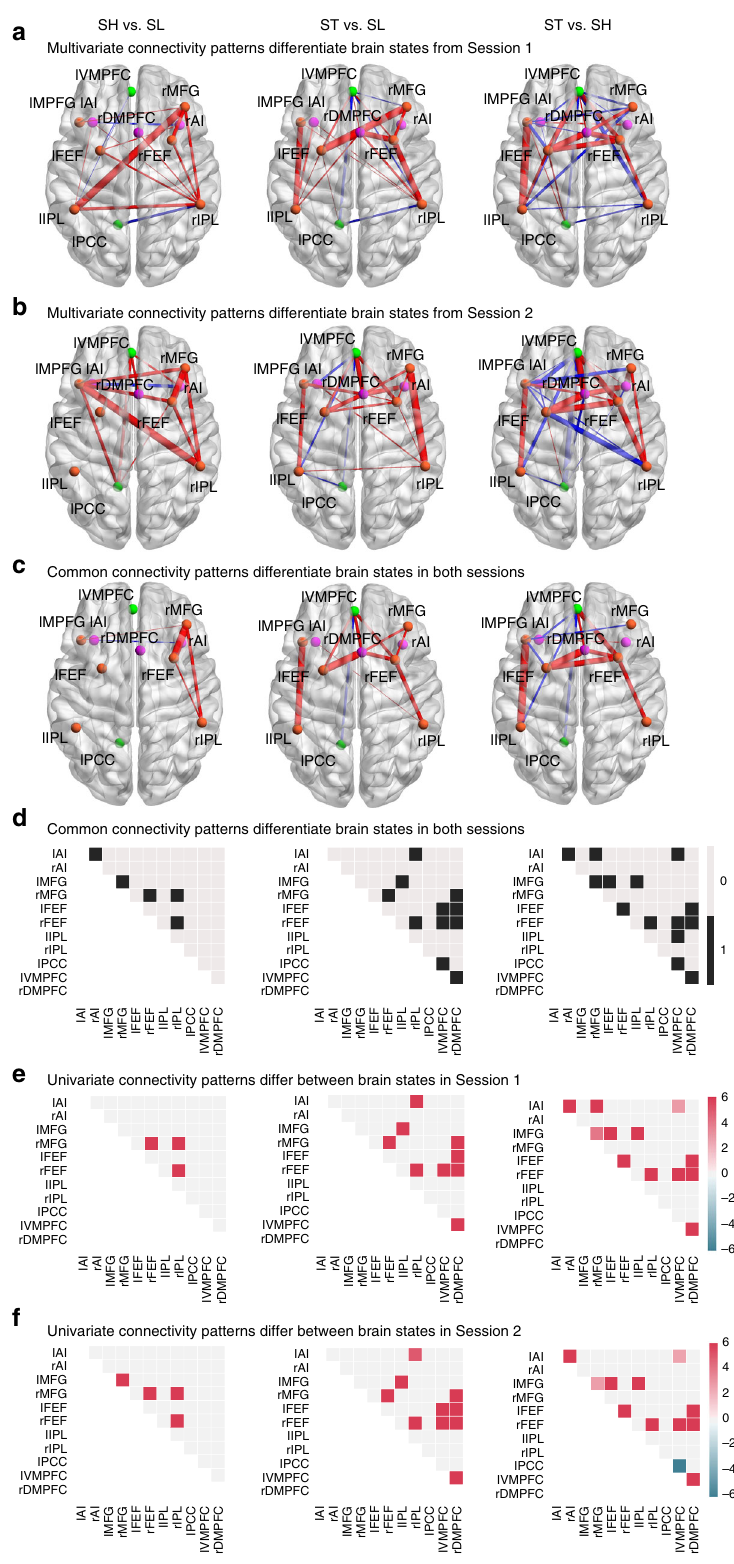
Fig. 6 Dynamic functional connectivity patterns that distinguish latent brain states. a , b Brain connectivity patterns that distinguish the latent states SH, SL, and ST in Sessions 1 and 2, respectively. The pink and orange nodes represent SN and CEN ROIs, respectively, activated during WM, while the green nodes represent DMN ROIs deactivated during WM. The red and blue edges represent positive and negative nonzero weights. c , d Common patterns of connectivity that distinguish latent states in both sessions. e , f Speci fi c links that showed signi fi cant differences in functional connectivity between latent brain states in Sessions 1 and 2, respectively. State SH, which dominates the 2-back WM task, showed higher frontoparietal connectivity compared to the state SL which dominates the 0-back low-load condition. Crucially, it was the transition state ST which had the strongest connectivity. Cells are color-coded and scaled by t -score ( p s < 0.05, two-tailed t -test, FDR corrected) NATURE COMMUNICATIONS| (2018) 9:2505 |DOI: